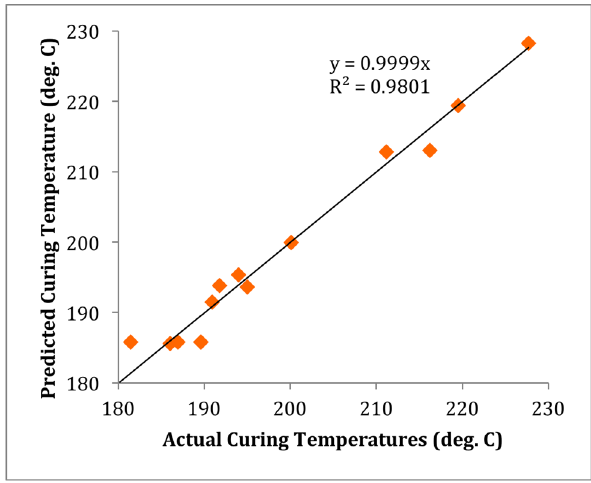
Figure 7. Residual vs. fitted values of the regression.